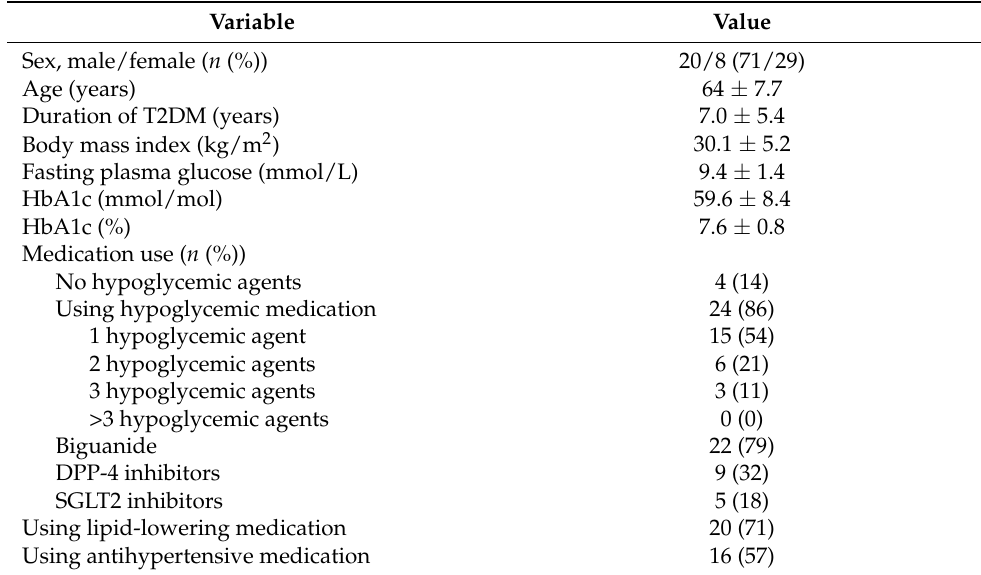
Table 1. Baseline characteristics of patients with T2DM.